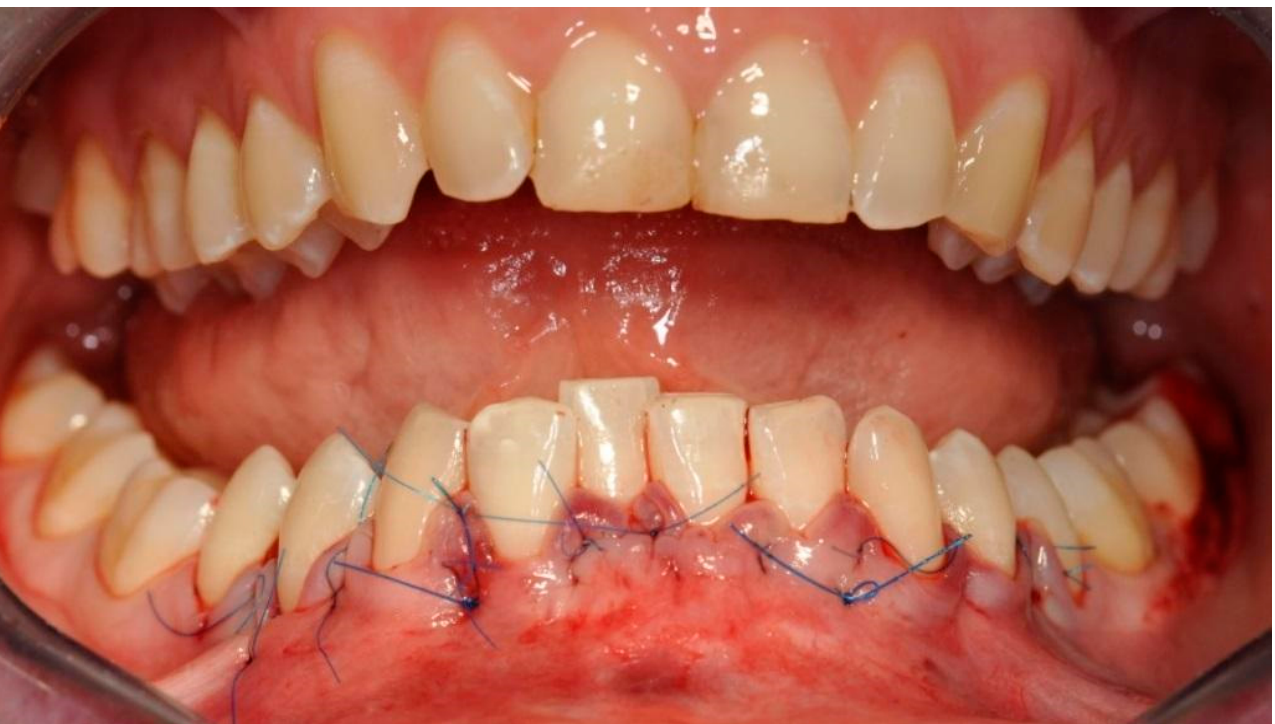
Figure 9. Reposition and suturing of the soft tissue without extensive tension.